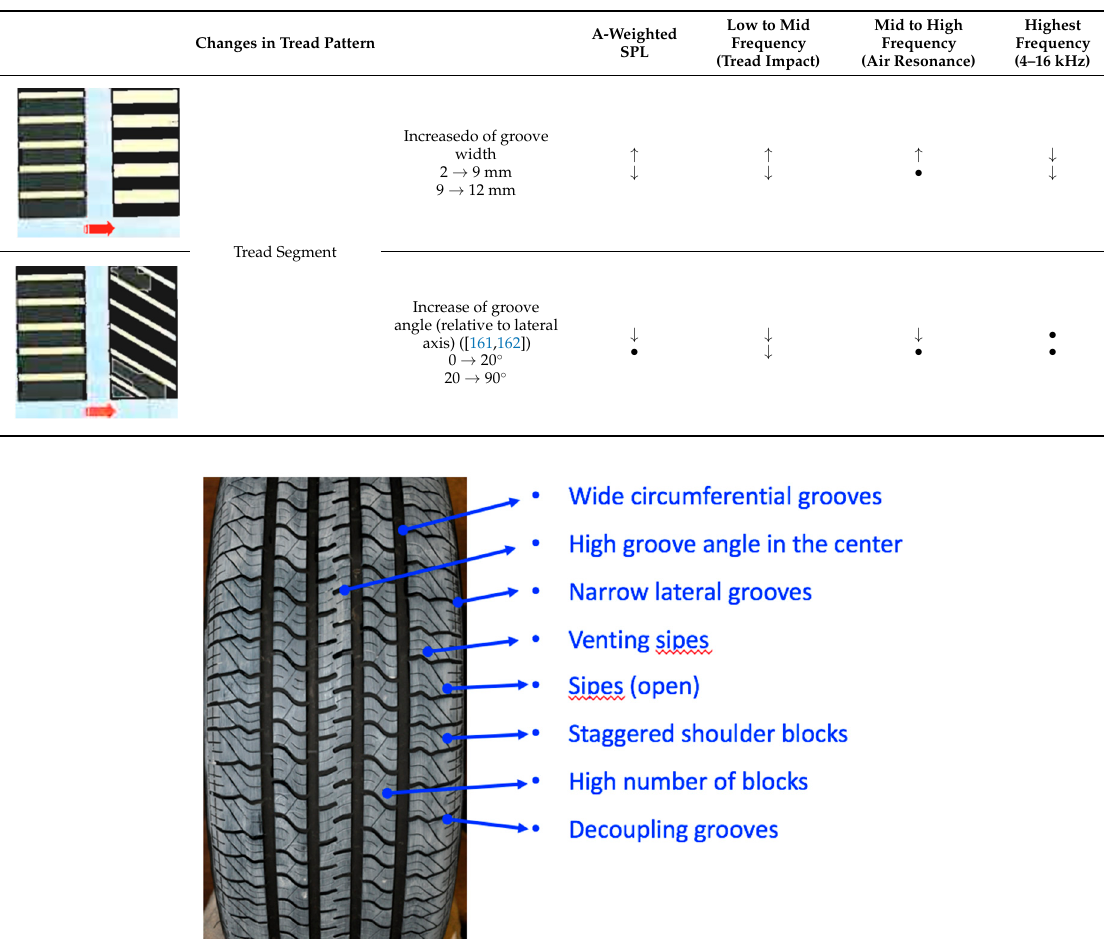
Figure 19. Example of a tread design with low TPIN characteristics (modified from Saemann, 2005 [159]; reprinted under fair use provision).